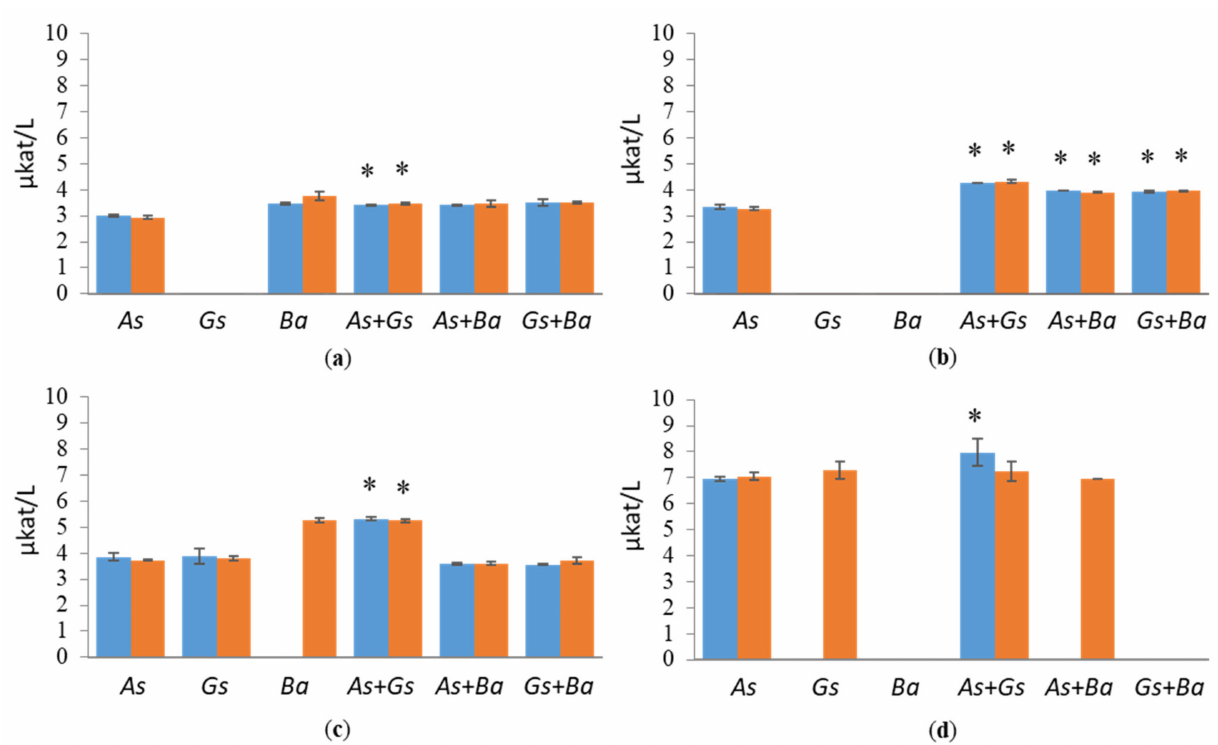
Figure 6. Endomannanase (MAN) activities at early (day 10, marked in blue) and late time points (day 24, marked in red) in single and co-cultivation on ( a ) birch, ( b ) spruce, ( c ) pine wood and ( d ) Avicel. As = A. sinuosa , Gs = G. sepiarium , Ba = B. adusta , As + Gs = A. sinuosa and G. sepiarium , As + Ba = A. sinuosa and B. adusta , Gs+Ba = G. sepiarium and B. adusta . Error bars refer to standard deviation (SD) ( n = 3). * indicates statistical difference among single and co-cultivations ( p < 0.05).